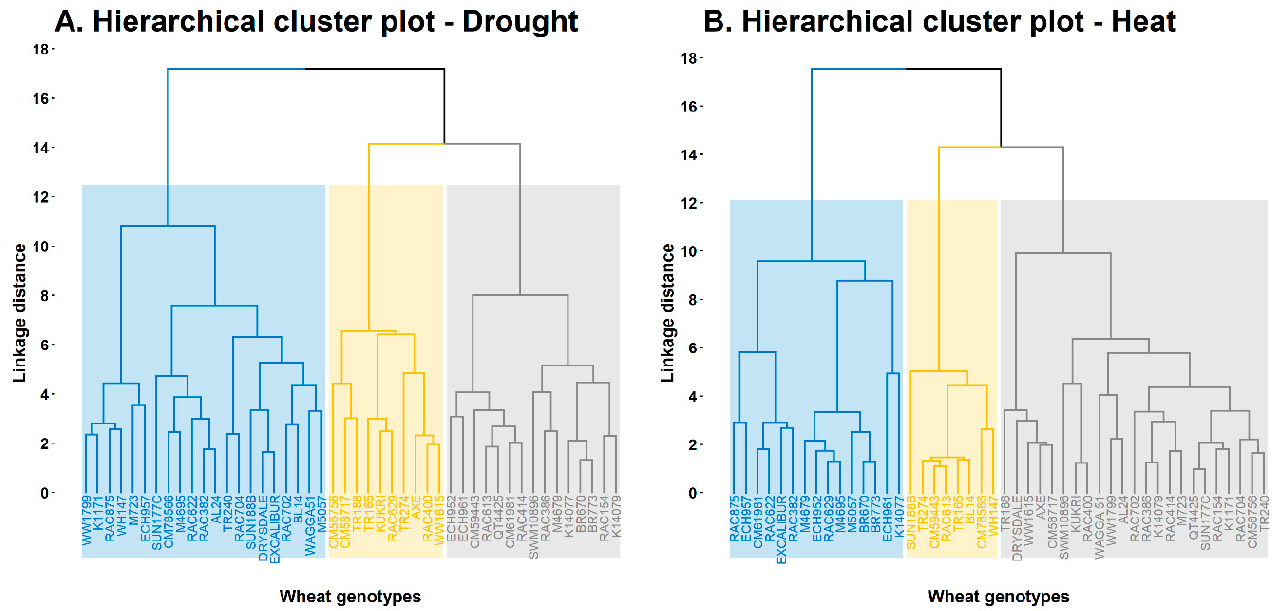
Figure 7. Hierarchical cluster analysis based on the similarity and dissimilarity of genotypes under ( A ) drought and ( B ) heat stress. The x -axis represents the genotypes, and the y -axis denotes the linkage distance of cluster pairs, where a higher value indicates a greater dissimilarity.